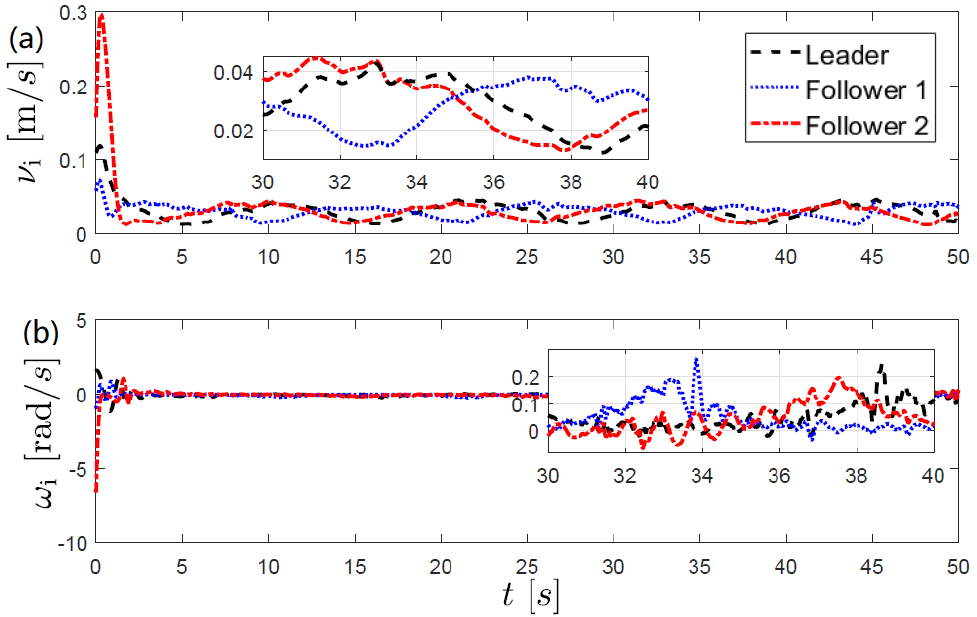
Figure 10. Control inputs obtained in the second experiment: ( a ) ν i , ( b ) ω i